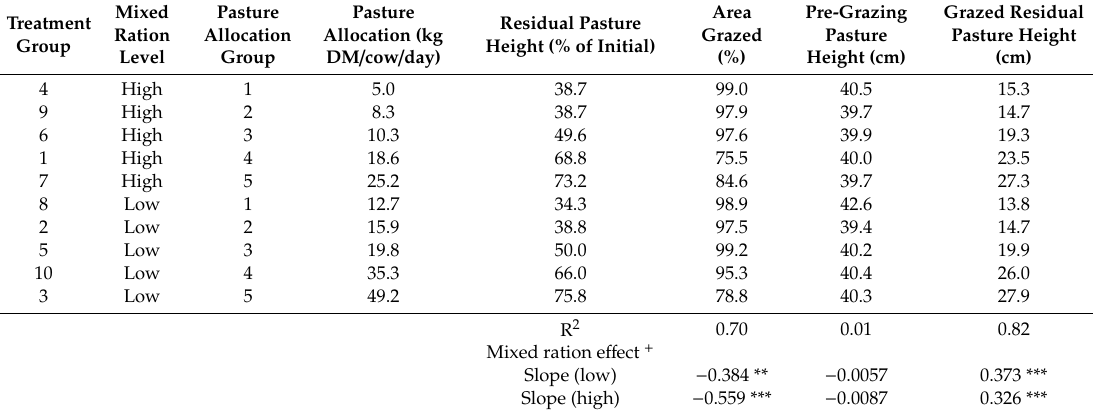
Table 3. Pasture height and defoliation intensity for each treatment group, arranged in increasing pasture allocations (kg dry matter (DM) / cow / day) for each mixed ration level. Treatment